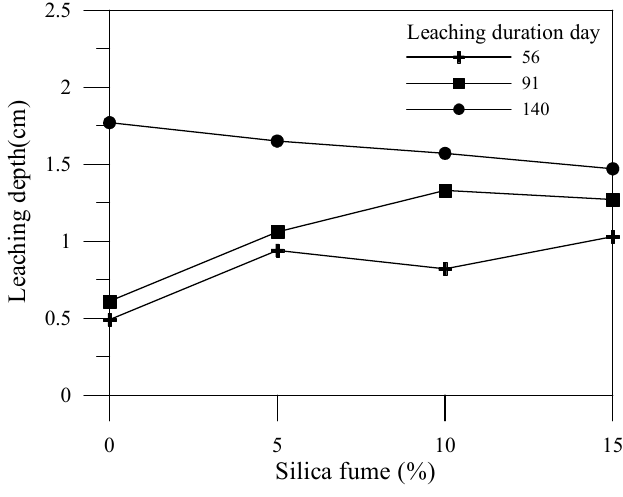
Figure 12. Effects of silica fume admixture amount on leaching depth and